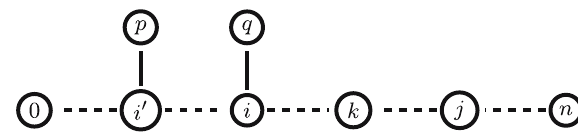
Figure 9: Minimum subgraph of C containing vertices {